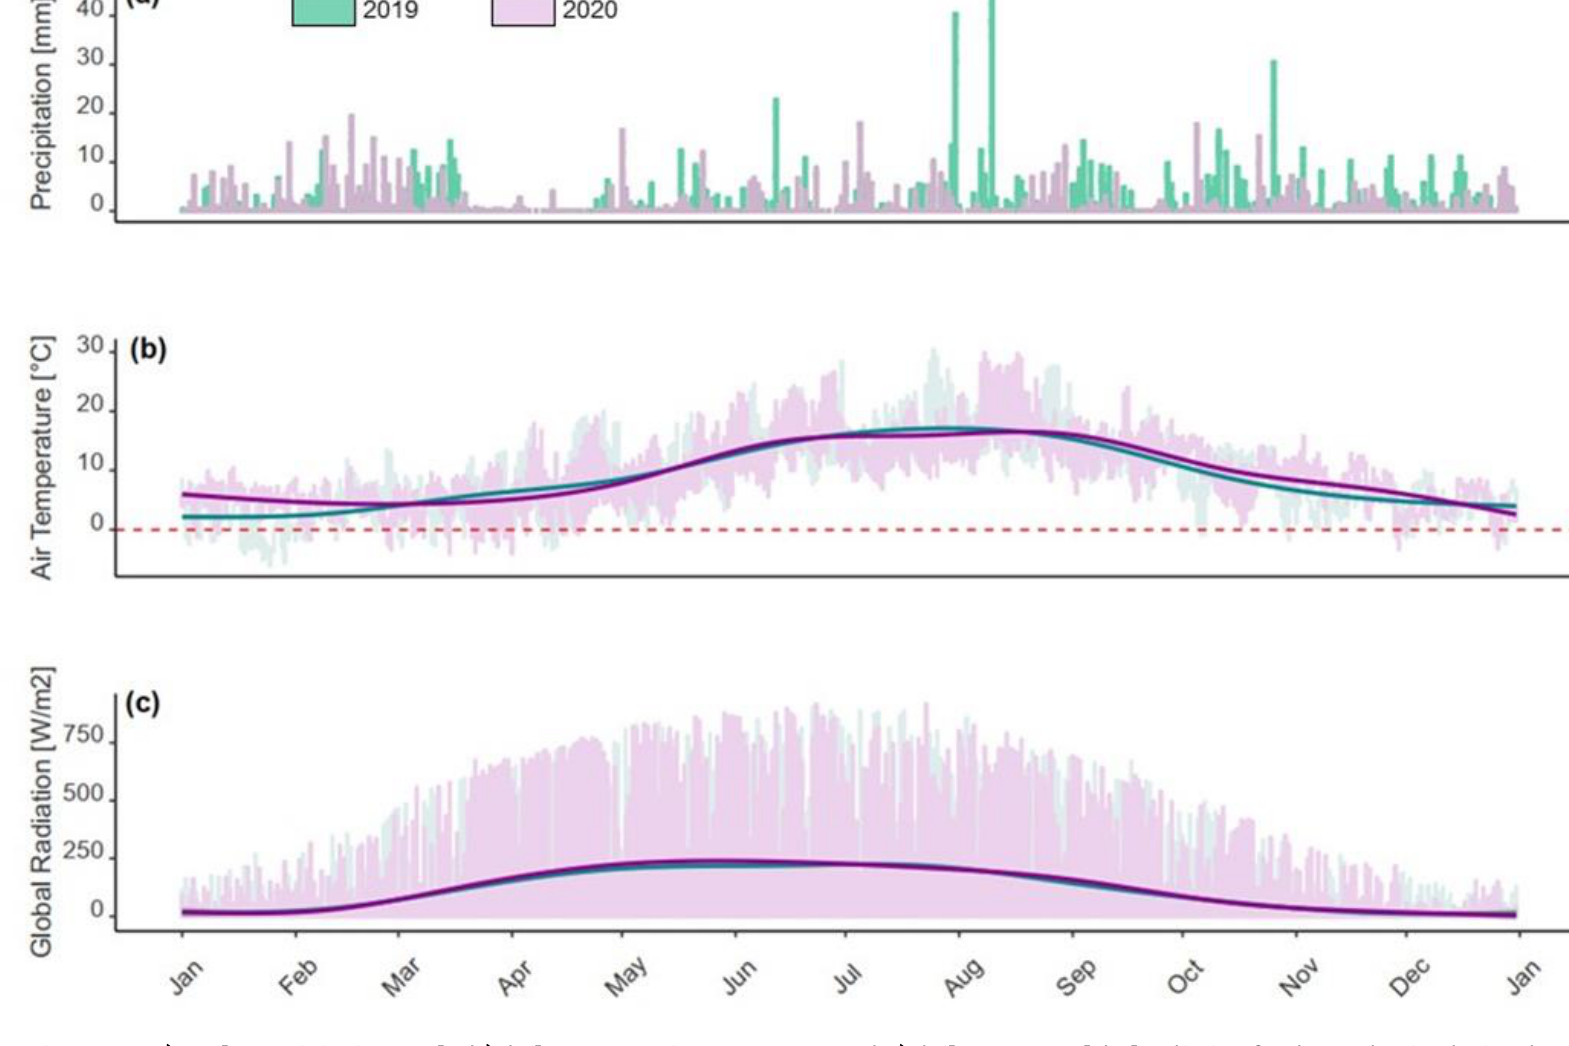
Figure A2. a) Daily precipitation totals; b) daily average air temperature; and c) daily average global radiation for the study site during the years 2019 (turquoise) and 2020